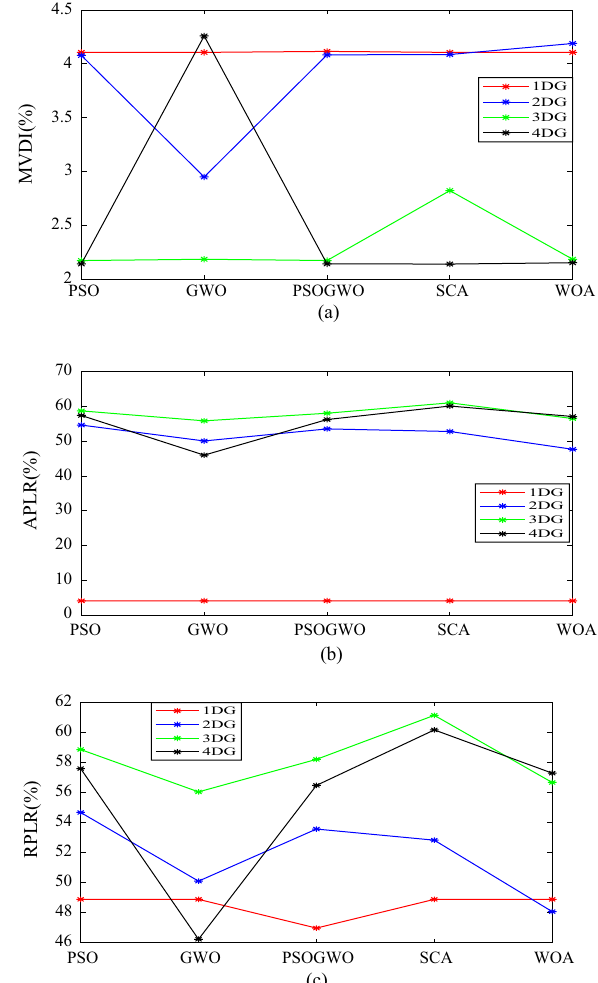
Figure 14. Comparison of different DGs and algorithms ( a ) for MVDI (%), ( b ) APLR (%), ( c ) RPLR (%). MVDI Maximum voltage deviation index, APLR active power loss reduction, RPLR reactive power loss